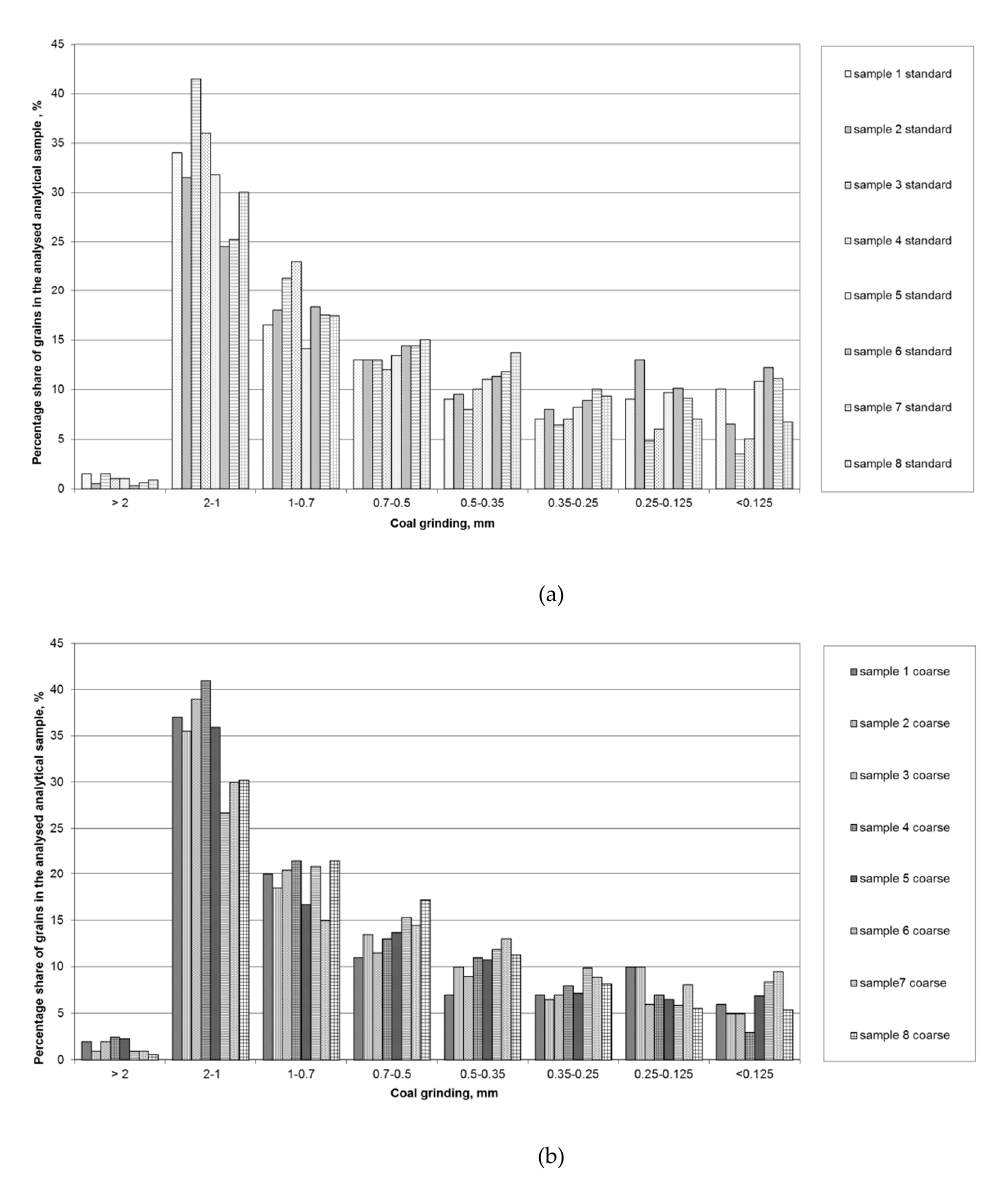
Figure 1. Grain analysis of coal samples: ( a ) standard and ( b ) coarsely crushed.